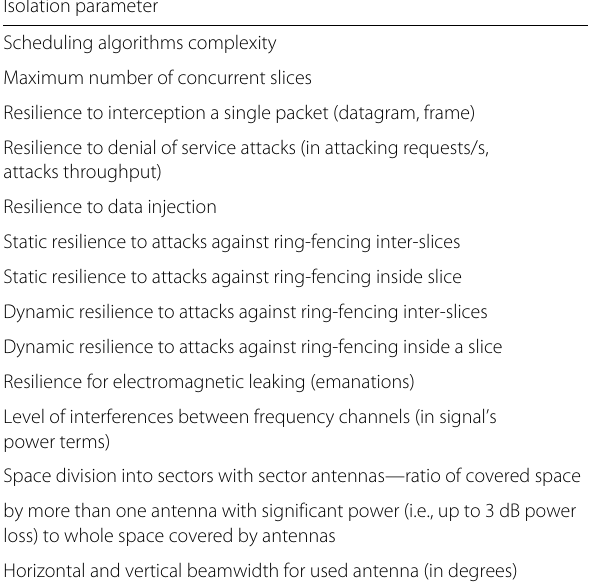
Table 2 Examples of isolation parameters Isolation parameter Scheduling algorithms complexity Maximum number of concurrent